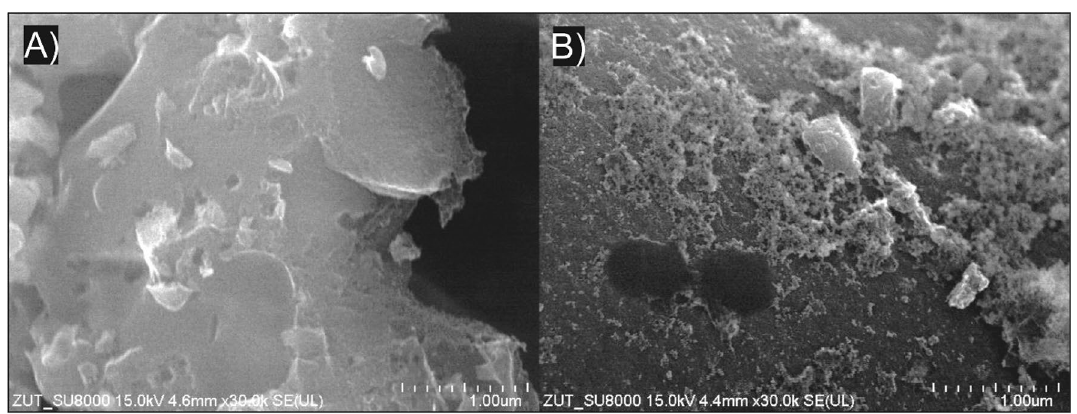
Figure 9. SEM images of the activated carbons before ( A ) and after ( B ) 11 months